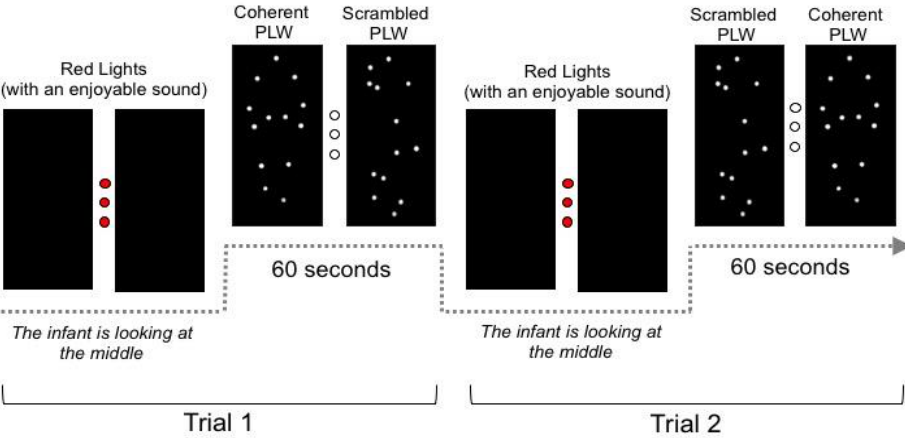
Figure 1. A schematic representation of the procedure in Experiment 1. Red lights were displayed at the beginning of each trial to attract infant’s attention to the middle of the screens. Only then, the experimenter triggered the beginning of the stimuli, and the coherent and scrambled point-light walkers (PLWs) were presented simultaneously for 60 s. Infants participated in a total of 6 trials.